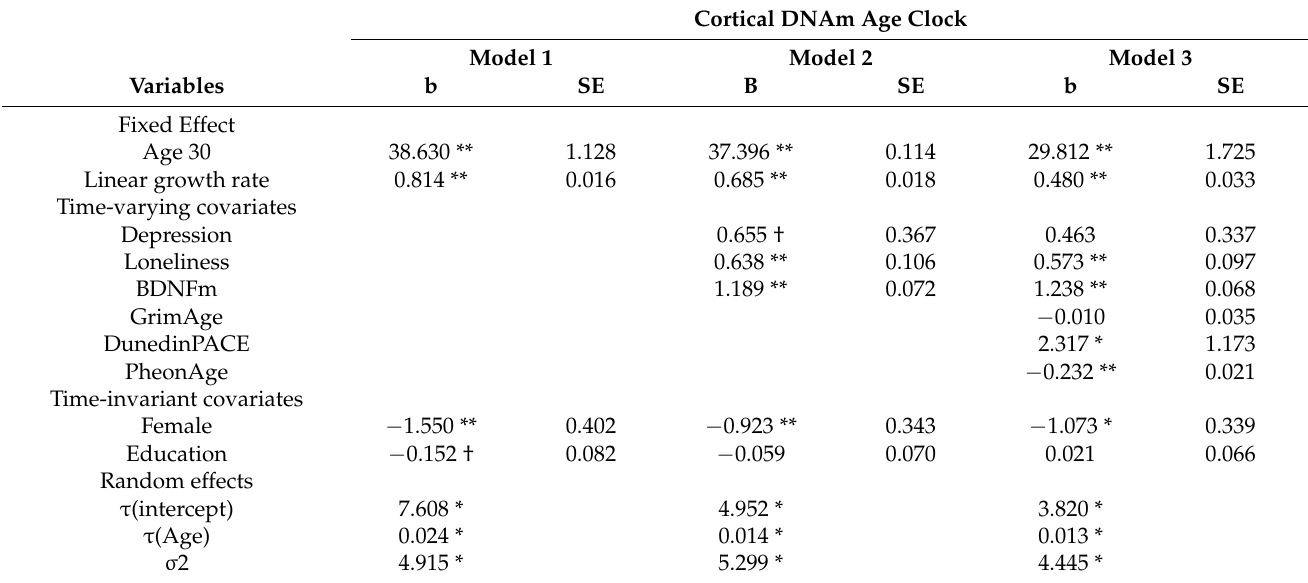
Table 3. Parameter estimates for linear growth models using time-varying and time-invariant covariates to predict accelerated CC-Bd ( n =